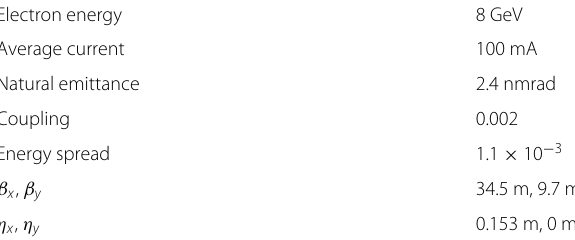
Table 2 Ring parameters at the long straight section of